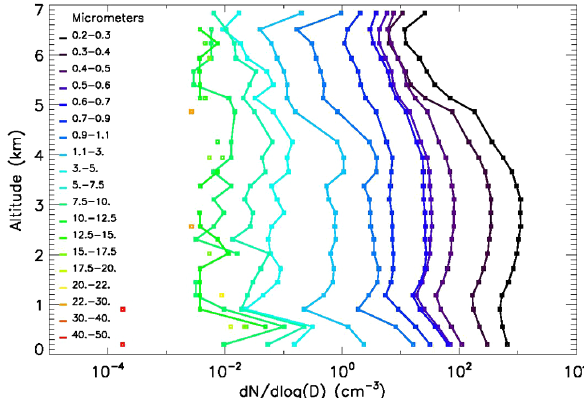
Figure 15. LOAC flight under a meteorological balloon from Mi- norca (Spain) on 18 June 2013 between 16:30 and 17:00UT during the ChArMEx campaign, inside a Saharan dust plume event; the un- certainty (at 1 σ ) is of about ± 20% for concentrations higher than 10 − 1 cm − 3 up to ± 60% for concentrations lower than 10 − 2 cm − 3